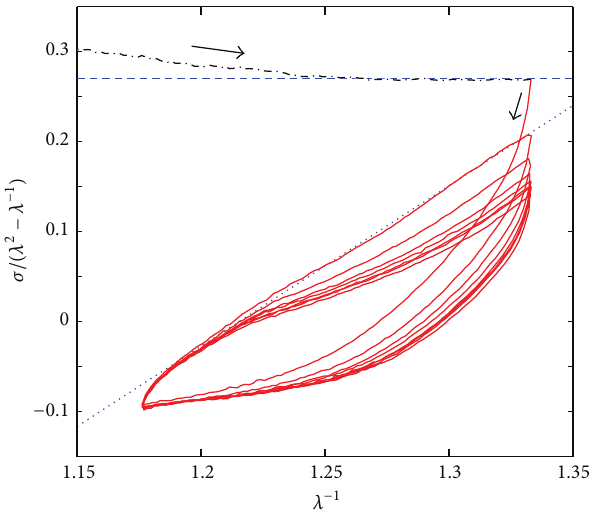
Figure 4: Mechanical behavior of cycling compression test of sample1.Measureddataareplottedindashed-dottedblackline(first compression) and red continuous line. Limit cases are plotted in dashed blue line (Neo Hookean nonviscous model using 𝐶 2 = 0 , constant value) and in dotted blue line (Mooney-Rivlin nonviscous model). The arrows indicate the time evolution.